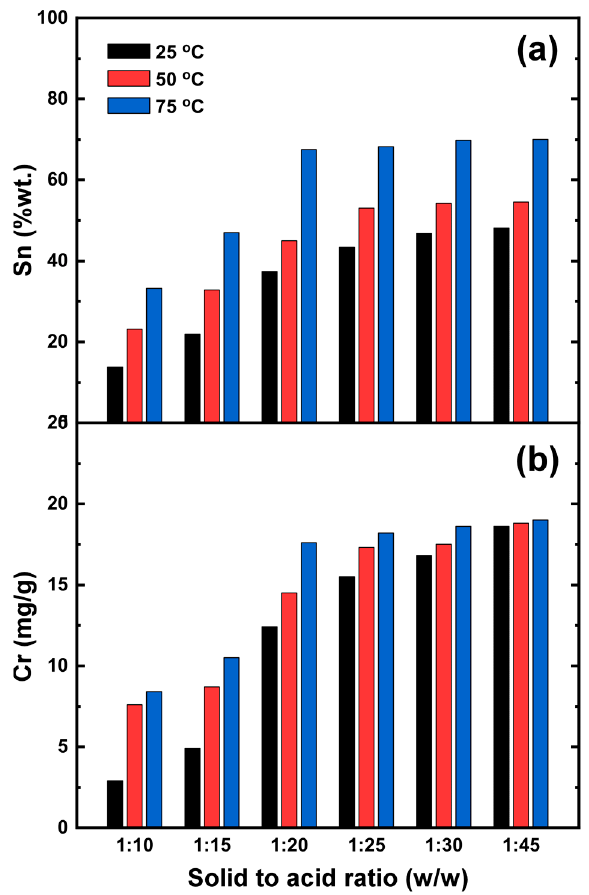
Figure 6. Influence of solid-to-acid mass proportion on Sn ( a ) and Cr ( b ) dissolution at different temperatures (C ads : 10 g/L, acid: HCl, t = 30 min).